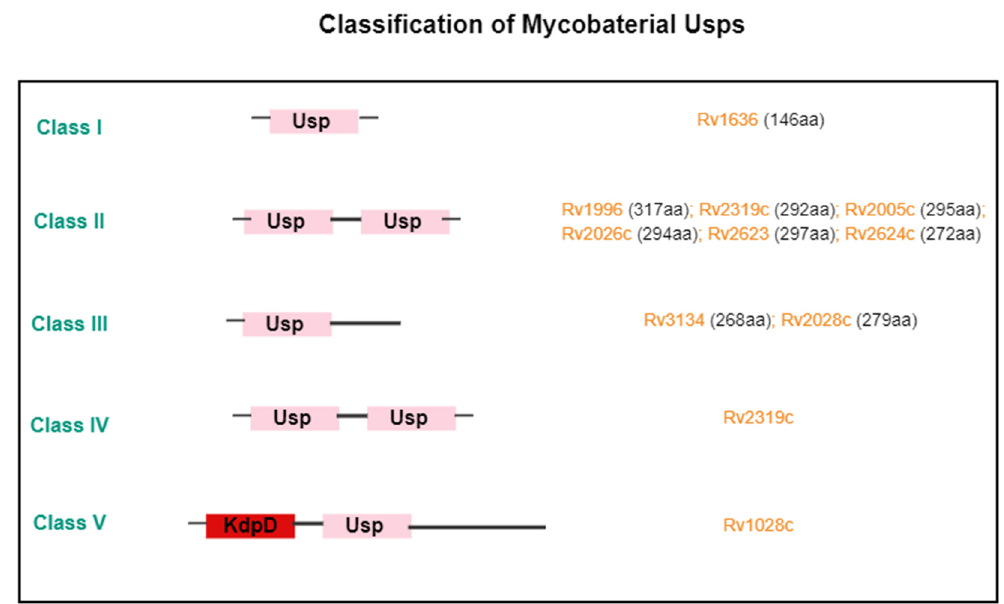
Figure 3. Classification of Mycobacterial USPs. Mycobacterial USPs are grouped into five classes, which altogether contain ten USPs .